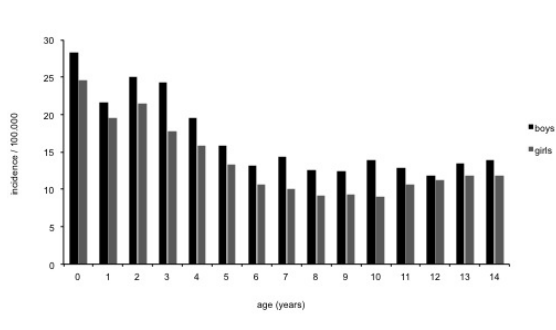
Figure 1. Age- and sex-specific incidence rates per 100.000 chil - dren less than 15 years in Germany (2003-2007) [ 2